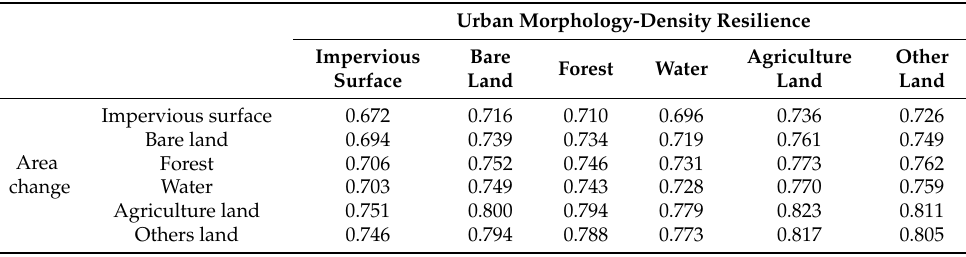
Table 7. The CCD between urban growth and urban morphology-density resilience of